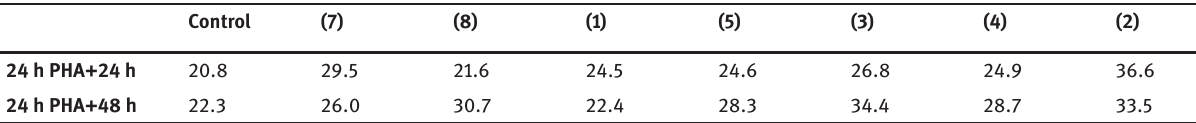
Table 3 : The percentage of apoptosis in PBL cultures. Control